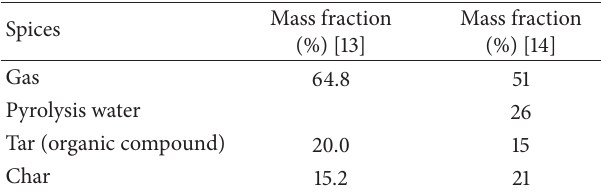
Table 3: Pyrolysis product of wood [13,